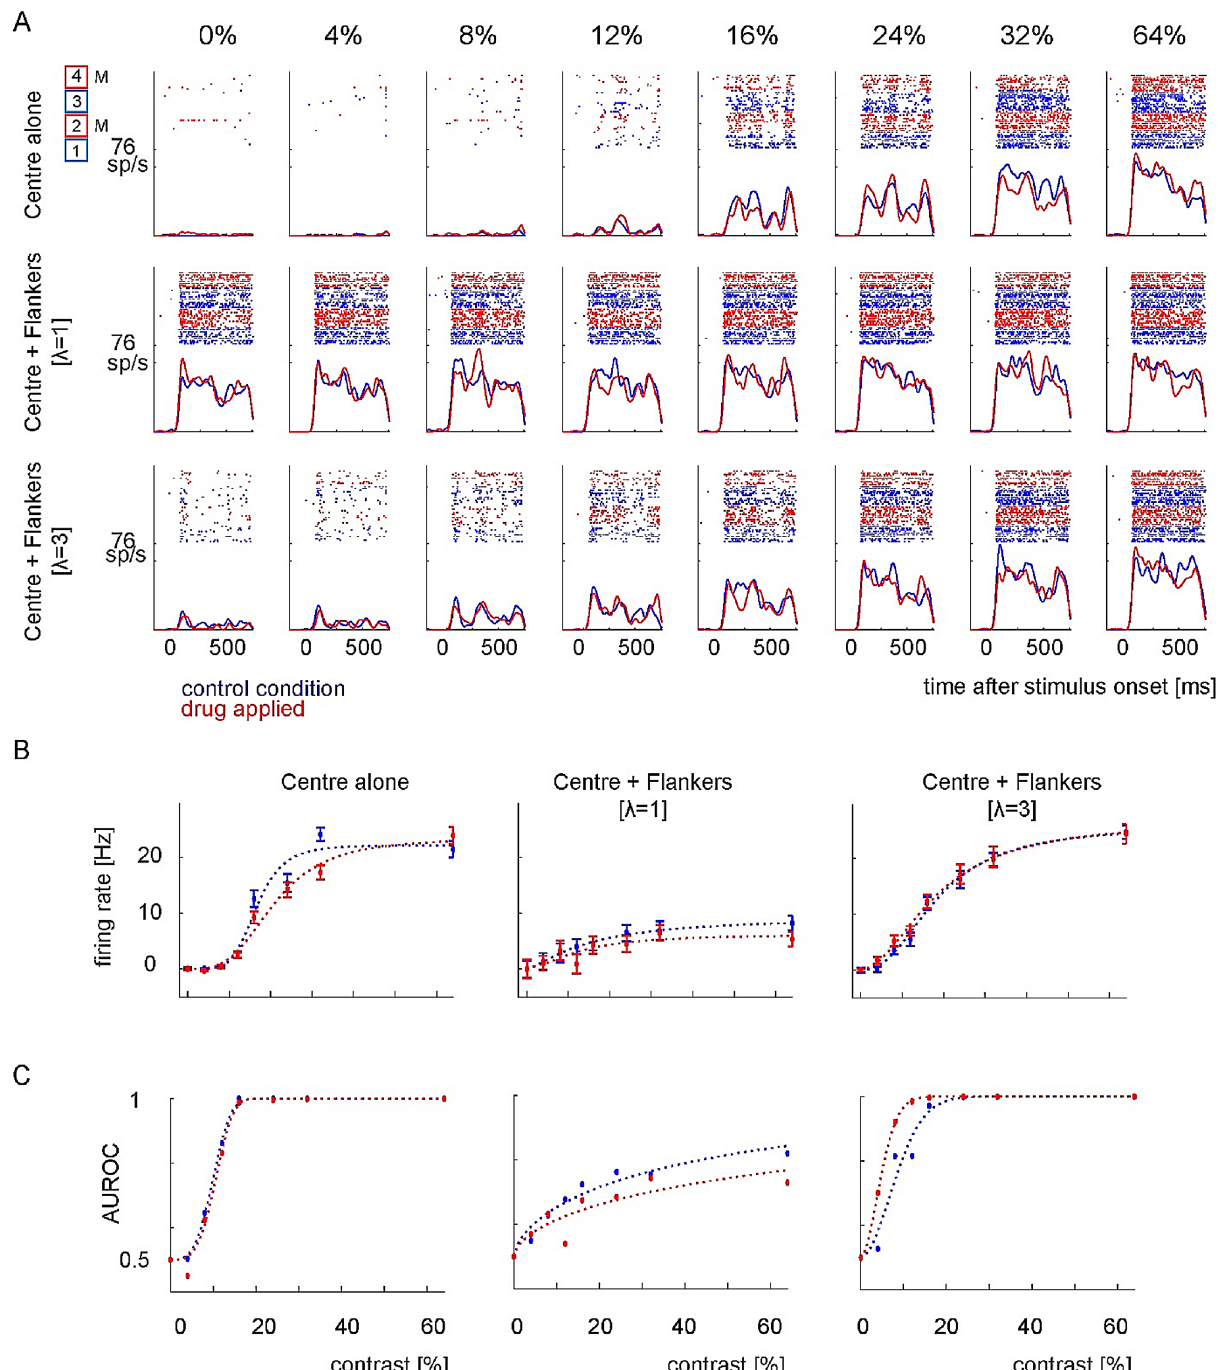
Figure 2. Effects of mecamylamine and collinear flankers on a representative sample neuron. ( A ) Single trial responses (raster plots) and peri-stimulus time histograms (PSTHs) of an example neuron during control (blue) and drug-applied (red) conditions. Each column shows a different contrast (indicated above the column) of the central Gabor (flanker contrast was fixed to 48%), and each row a different flanker condition. First we recorded responses when mecamylamine was not applied (blue rasters histograms, symbols and lines, Box 1), followed by responses when mecamylamine was applied (red rasters histograms, symbols and lines Box 2, M indicates mecamylamine application), a recovery period (Box 3), and another mecamylamine applied period (Box 4). The first 2 trials from each block are not shown as they were excluded from the analysis. The appearance of a central Gabor elicited a response that increased with the contrast of the stimulus. Mecamylamine generally decreased the responses. In the absence of a central Gabor (0% contrast), flankers at closer distances increased responses to a greater extent than flankers at longer distances due to intrusion in the receptive field. sp/s = spikes per second. ( B ) Contrast R target functions of the cell shown above in the absence (blue) or presence (red) of scopolamine for the different flanker conditions. Mecamylamine decreased Rmax for the flanker distance of 1λ, and it increased c50 when no flankers were present. ( C ) contrast response functions assessed using AUROCs. Mecamylamine had no effect on contrast sensitivity when no flankers were presented, it increased the threshold at a flanker distance of 1λ, but decreased the threshold at a flanker distance of